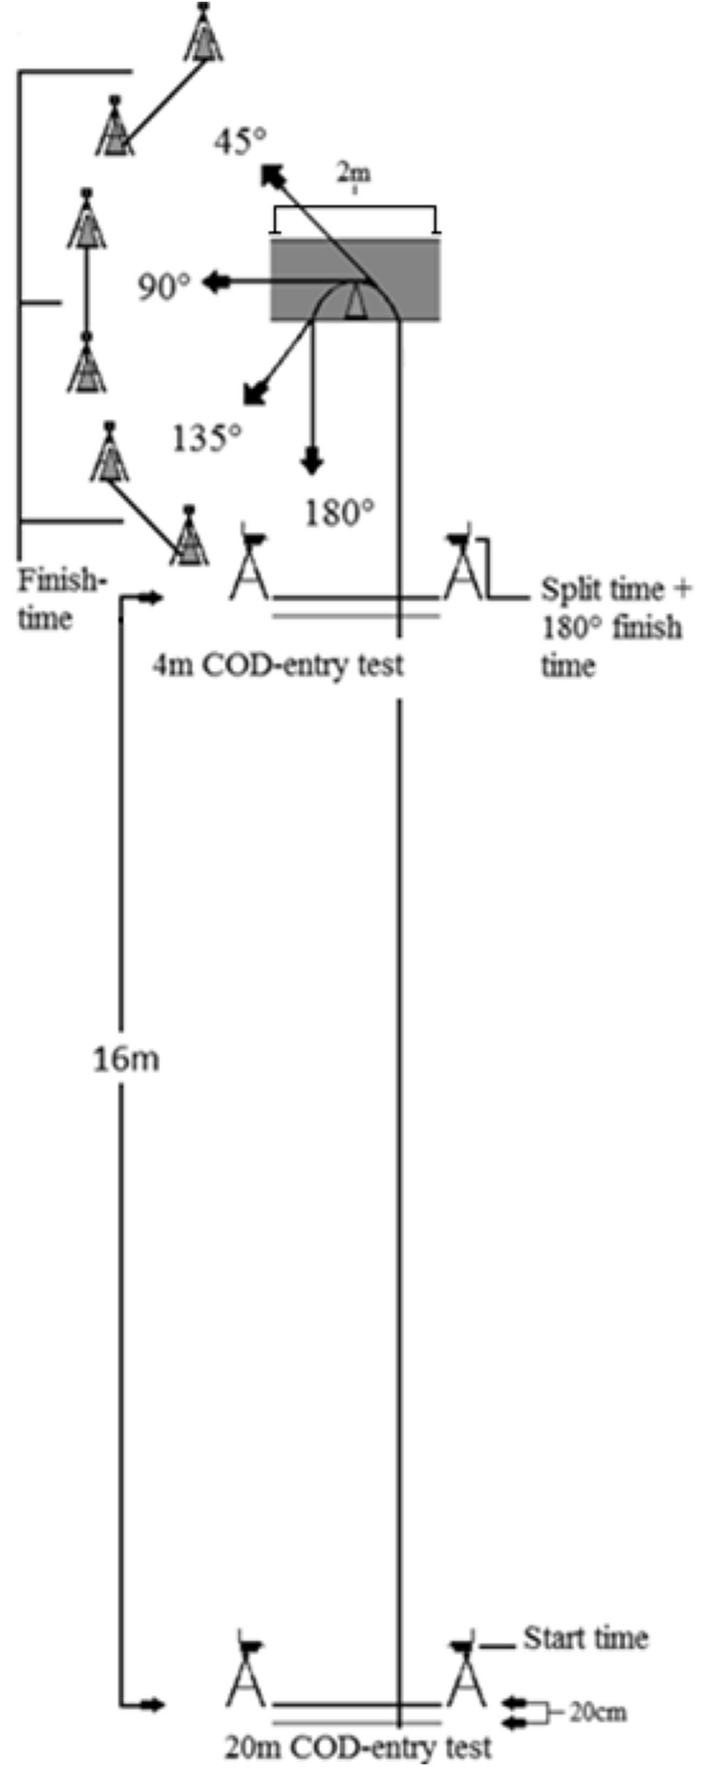
COD tracks. Illustration of dimensions for setup and testing.